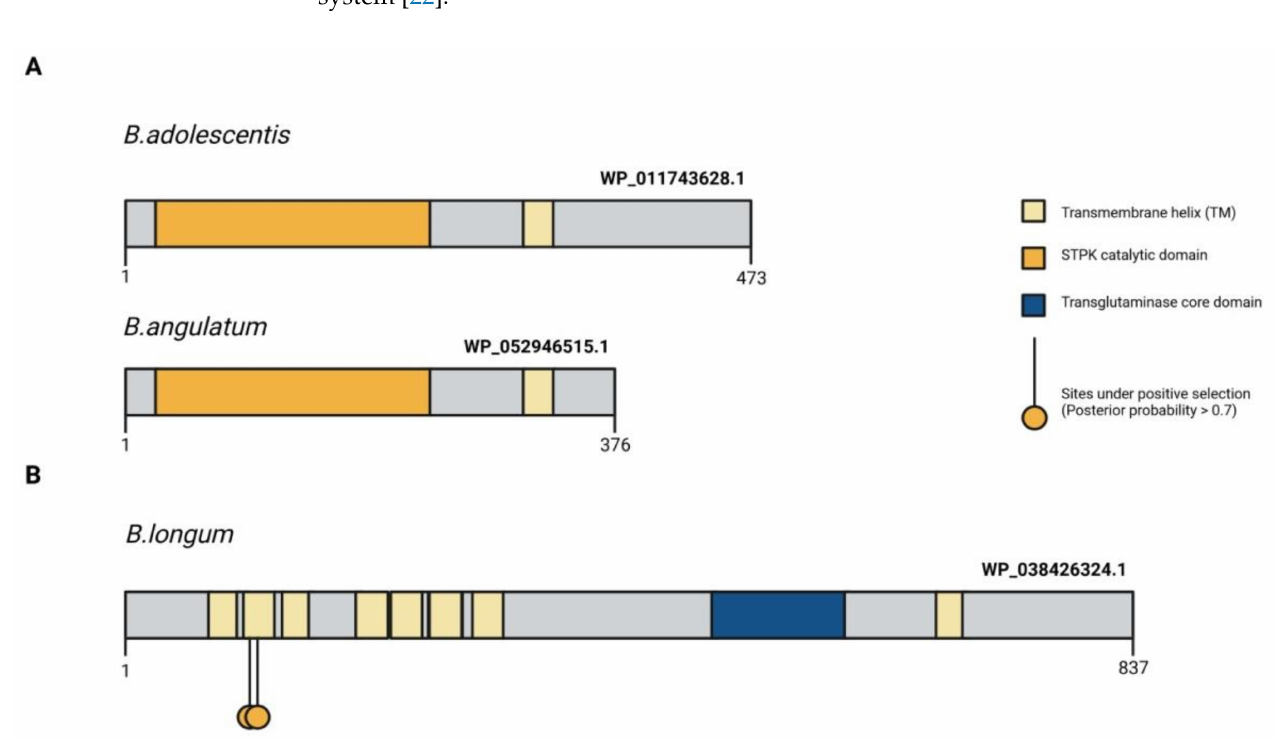
Figure 3. Protein structure of the signal-transduction domains of the PFNA operon potentially involved in interaction with the host organism. ( A ) Comparison of the primary structure of STPK Pkb2 between B. angulatum and B. adolescentis species both belonging to the B. adolescentis phylogroup. Pkb2 contains a catalytic kinase domain, a transmembrane domain (TM), and a C-terminal signal region [23]. ( B ) Localization of amino acid sites under pervasive positive selection in all branches of the bifidobacterium phylogenetic tree in the primary structure of the WP_038426324.1 protein encoded by the tgm gene in B. longum subsp. longum GT15 genome. The figure shows the domain organization of the protein, as well as the localization of candidate sites with a PP value > 0.7 [23]. Adapted from